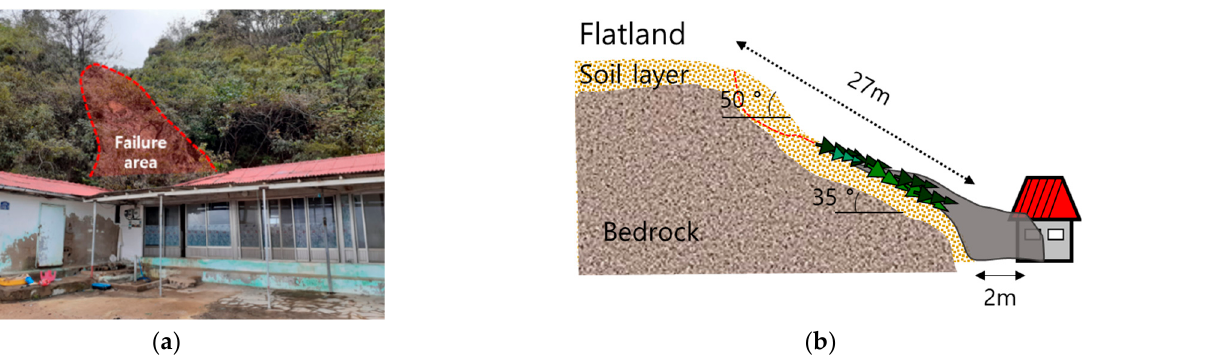
Figure 12. Schematic representation of full-scale flume experiment set up with soil profiles. A full-scale flume experiment was performed two times in Table 5. In the second experiment, some of the measurement positions were adjusted according to the feedback based on the results of the first experiment. Figure 13a,b shows the failure process of the first full-scale flume experiment. Ap- proximately 5 h and 28 min after spraying artificial rainfall with a rainfall intensity of 50 mm/h, local small-scale failure occurred at the boundary of the berm part on the slope (Figure 14a). This is the position at which failure frequently occurs in the field. The posi- tion also appears to be most vulnerable to failure in this experiment. At 11 h and 16 min, the second collapse occurred; at this stage, the entire soil layer on the slope collapsed and shallow failure occurred.